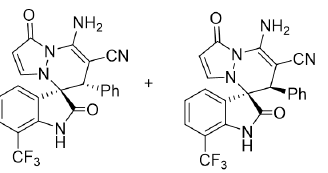
Molecules 2023 , 28 ,